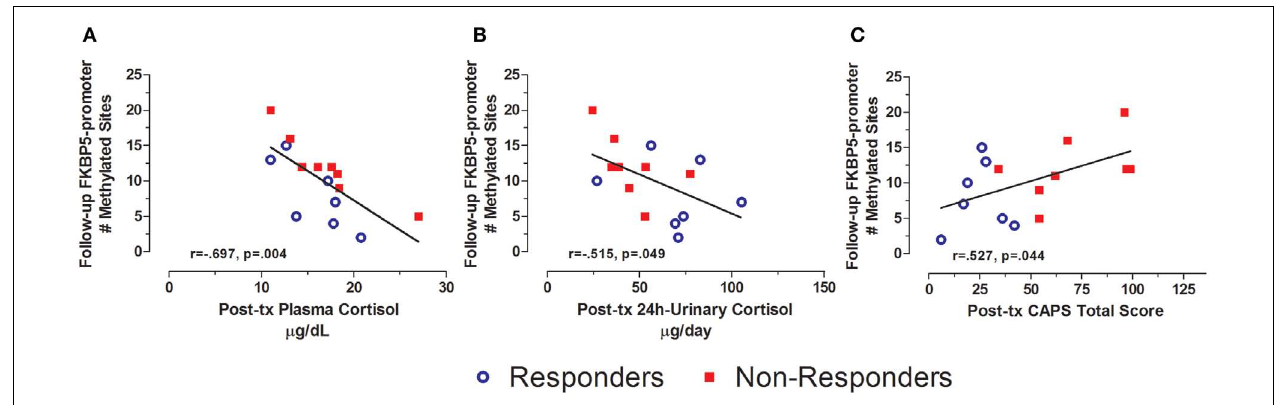
circles and non-responders ( n = 8) by red squares. Both higher plasma cortisol and higher 24h-urinary cortisol associated with lower FKBP5 promoter methylation at follow-up. Higher post-treatment CAPS total scores associated with more FKBP5 promoter methylation at follow-up. Correlation coefficients are denoted in the different panels. Statistical significance was set at p < 0.05.